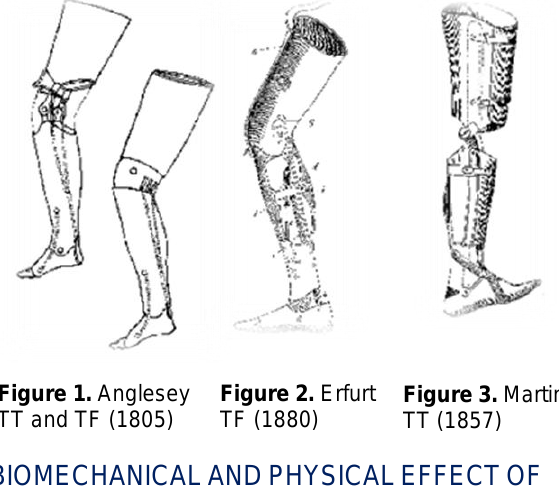
Figure 3. Martin TT